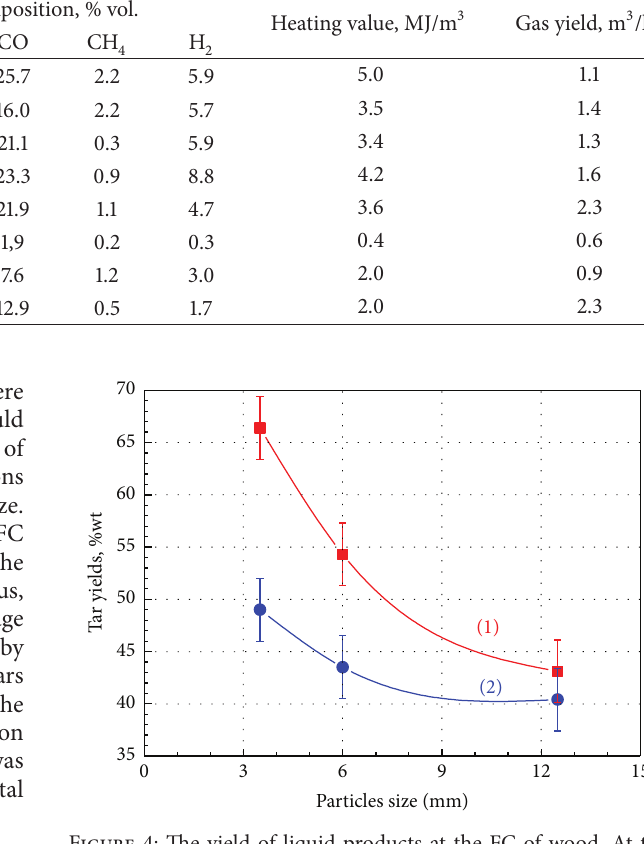
Figure 4: The yield of liquid products at the FC of wood. At the wood content in the mixture 33% (1), and at the wood content of 100%